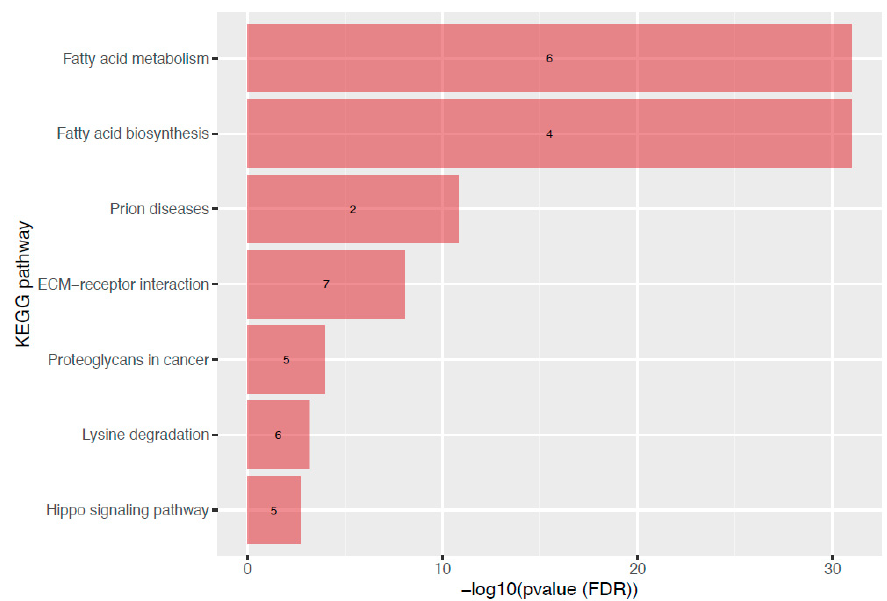
Figure 2. KEGG pathways targeted by miRNAs associated with maternal BMI at the first trimester of pregnancy. This bar graph is showing the KEGG pathways enriched with targets of miRNAs associated with maternal BMI. Each bar represents one pathway, ranked according to its level of significance (FDR adjusted q-value). The number of miRNAs involved in the pathway is shown directly in the bar. Abbreviations: ECM: extracellular matrix; FDR: false discovery rate; KEGG: Kyoto Encyclopedia of Genes and Genomes.